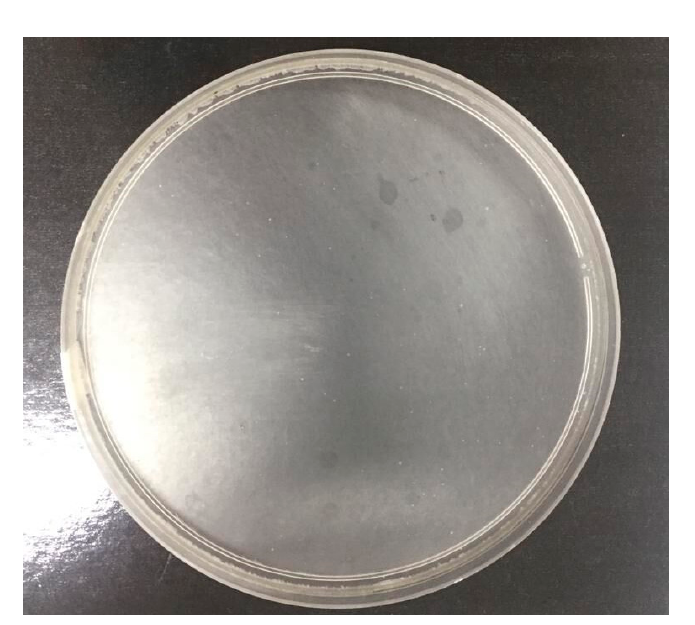
Figure 4. Physical appearance of CS film. Table 6. Characterization of nanobiocomposites (mean ± standard deviation).